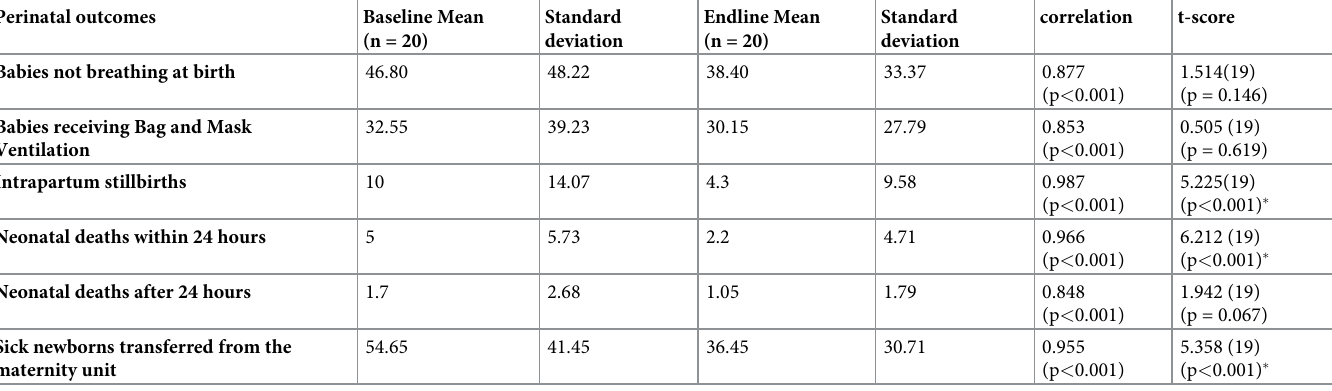
Table 3. T-test and suitability of dependent sample t-test.